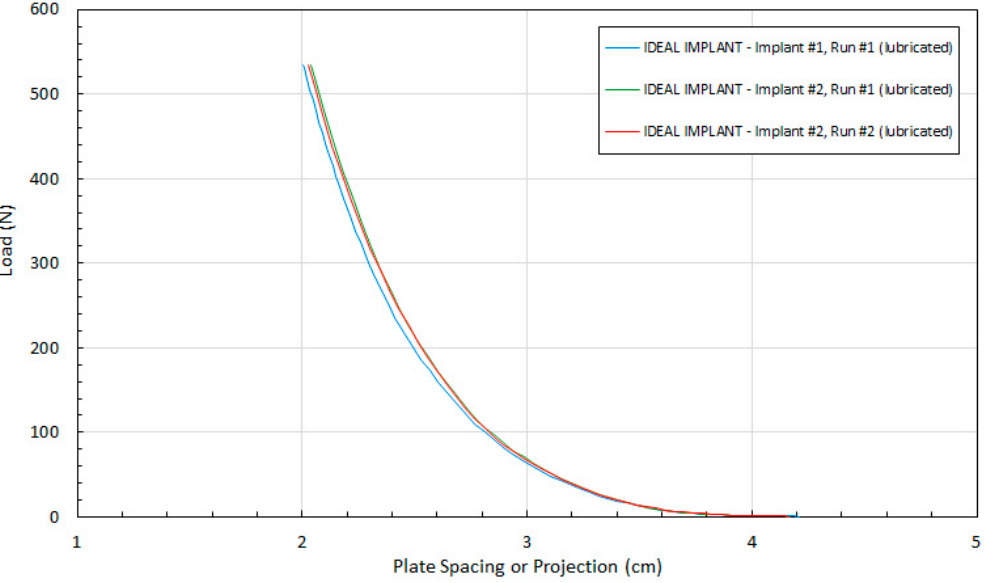
Figure 5. Reproducibility of Implant Projection Measurements.